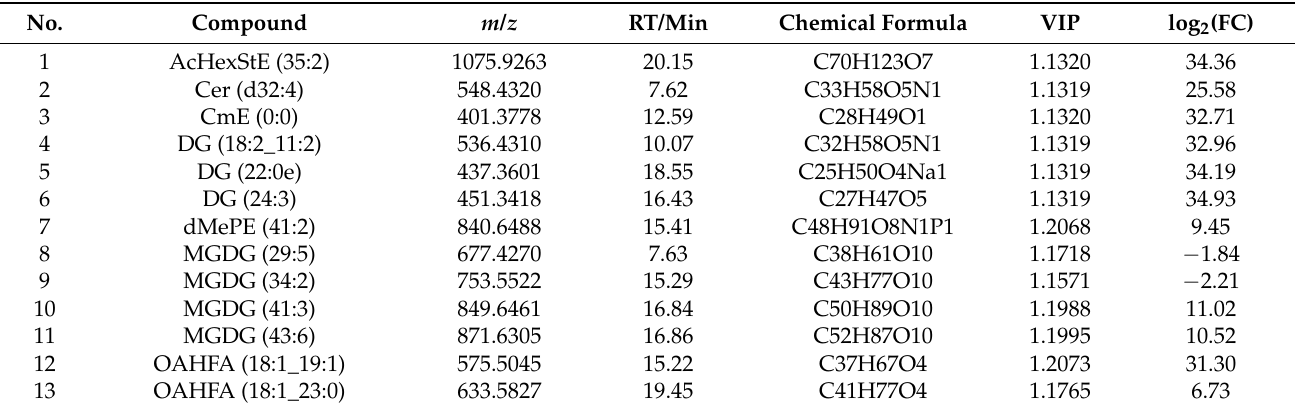
Table 8. Statistical table of specific differential lipids in